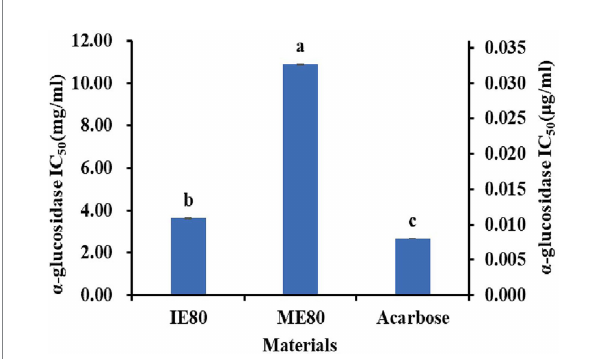
FIGURE 3 The α -glucosidase inhibitory activities of different instant powder samples. The left y-axis represents the IC 50 scale of the sample, and the right y-axis represents the IC 50 scale of the acarbose. Different letters (a, b, c) indicate significant differences ( p <